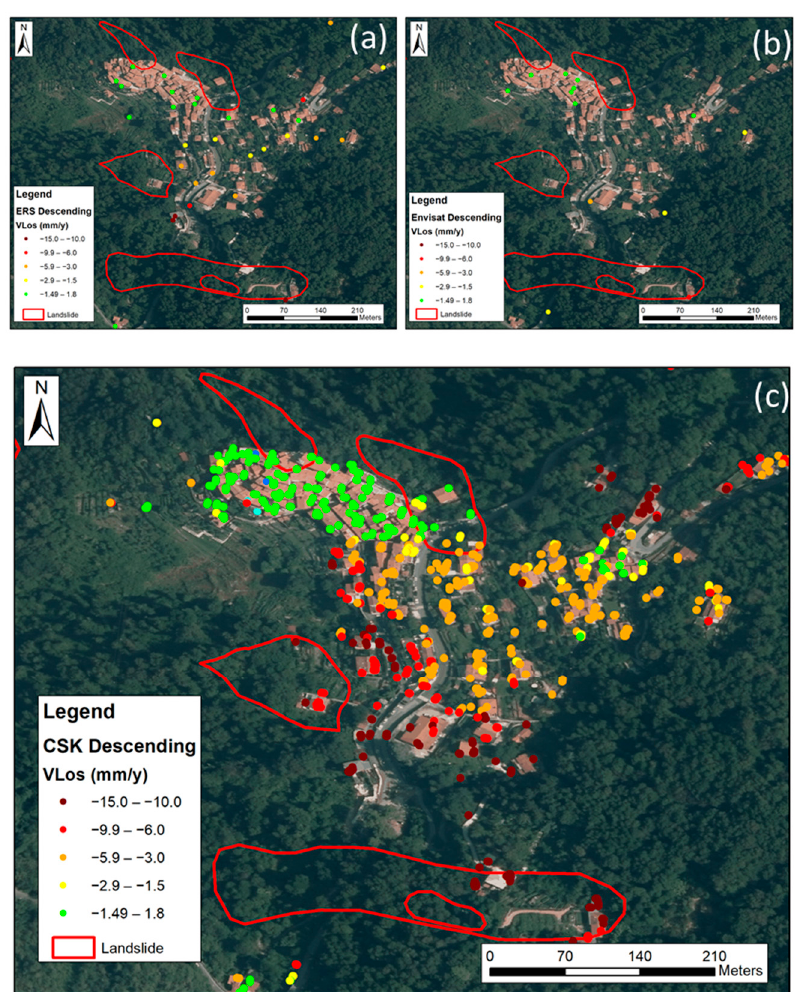
Figure 5. Ground LOS deformation velocity maps of the village of Pariana: ( a ) ERS descending (1992–2000); ( b ) Envisat descending (2003–2010) and ( c ) COSMO-SkyMed descending (2010–2014). Red polygons correspond to landslides mapped in the Landslide inventory map of the Tuscany region.